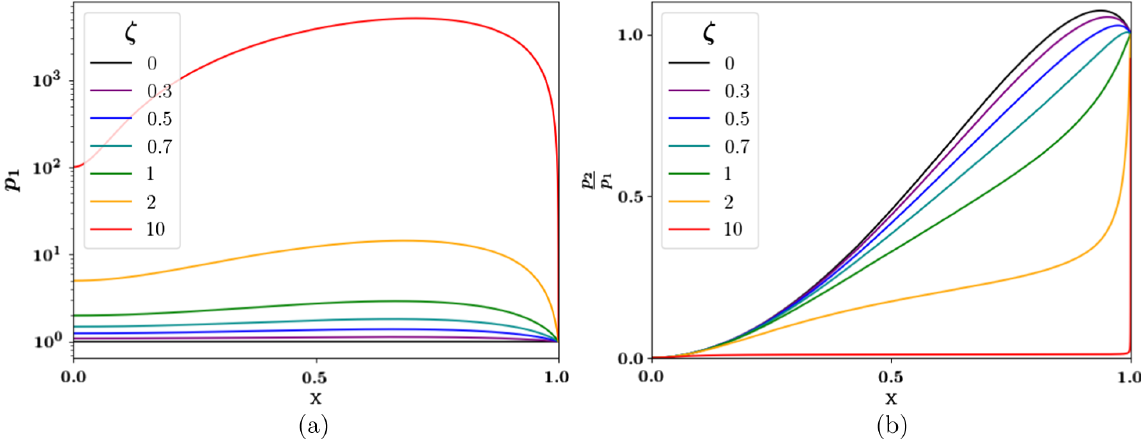
p 1 ð x Þ ð 1 þ 3 2 D 03 p 2 ð x Þ Þ , where p 1 , p 2 , g 1 , and g 2 are defined in the text. Notice that g 1 ð 1 Þ g 2 ð x Þ p 1 ð x Þ r 0 is plotted in (b). Notice that the value of this second function for a specific x in (0,1) p 1